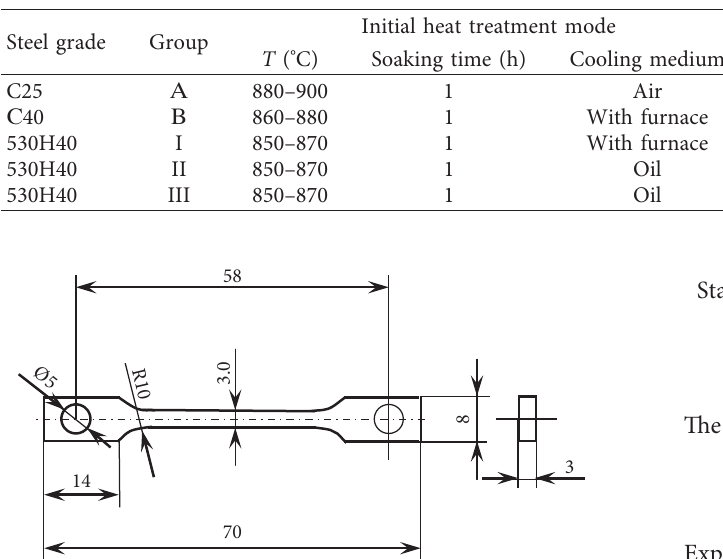
Figure 1: Shape and size of samples for microplasticity